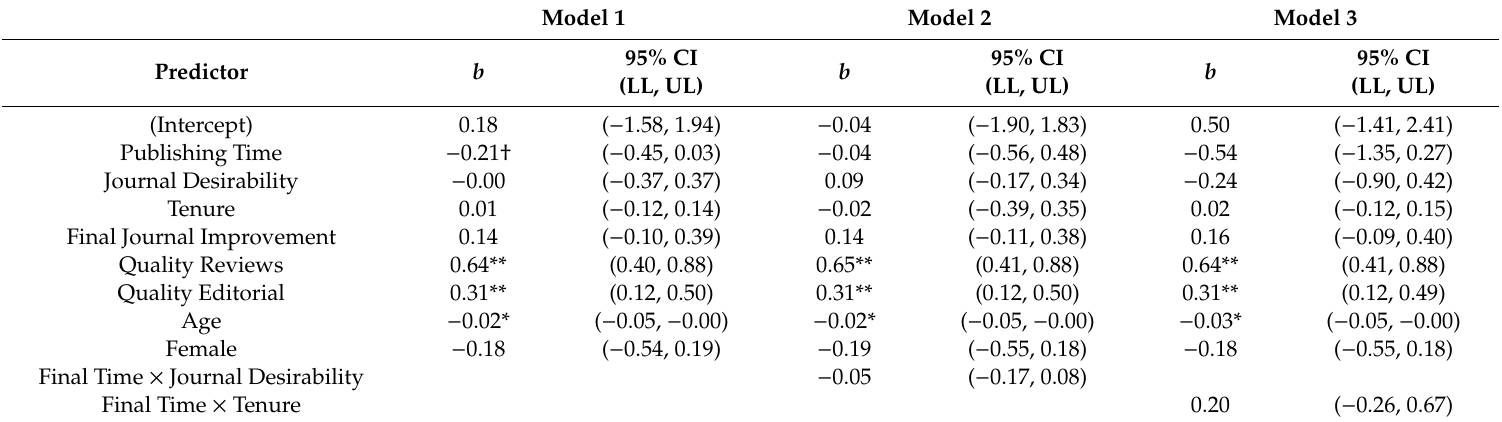
Table 2. Regression